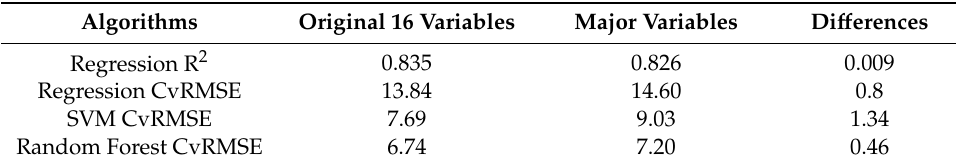
Table 8. Verification of error rates with three